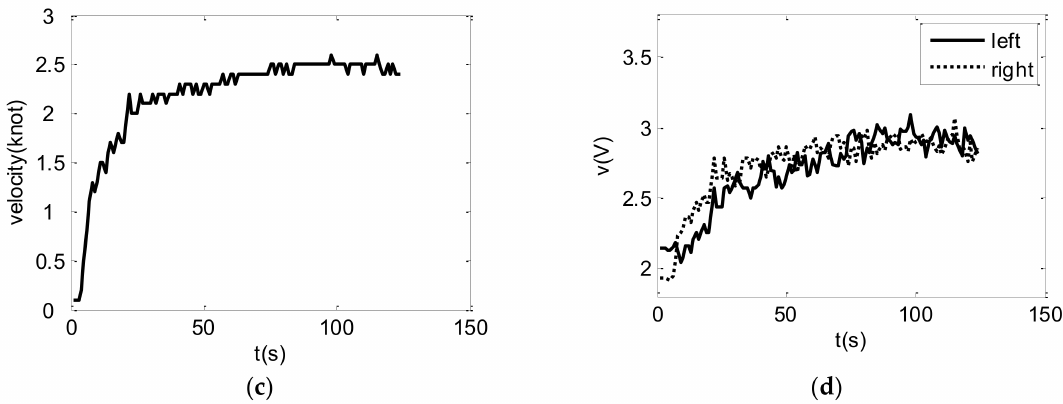
Figure 5. Experiment result for heading and velocity control: ( a ) the USBV in the lake experiment; ( b ) autonomous control for 180 ◦ expected heading; ( c ) autonomous control for 2.3 knot expected velocity; and ( d ) the control voltage of left and right